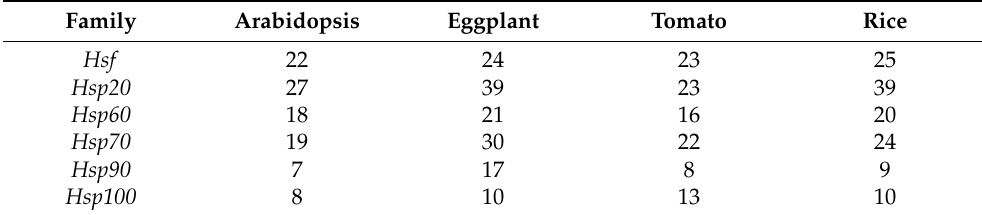
Table 1. Numbers of Hsf and Hsp genes in Arabidopsis, eggplant, tomato and rice. Family Arabidopsis Eggplant Tomato Rice Hsf 22 24 23 25 Hsp20 27 39 23 39 Hsp60 18 21 16 20 Hsp70 19 30 22 24 Hsp90 7 17 8 9 8 10 13